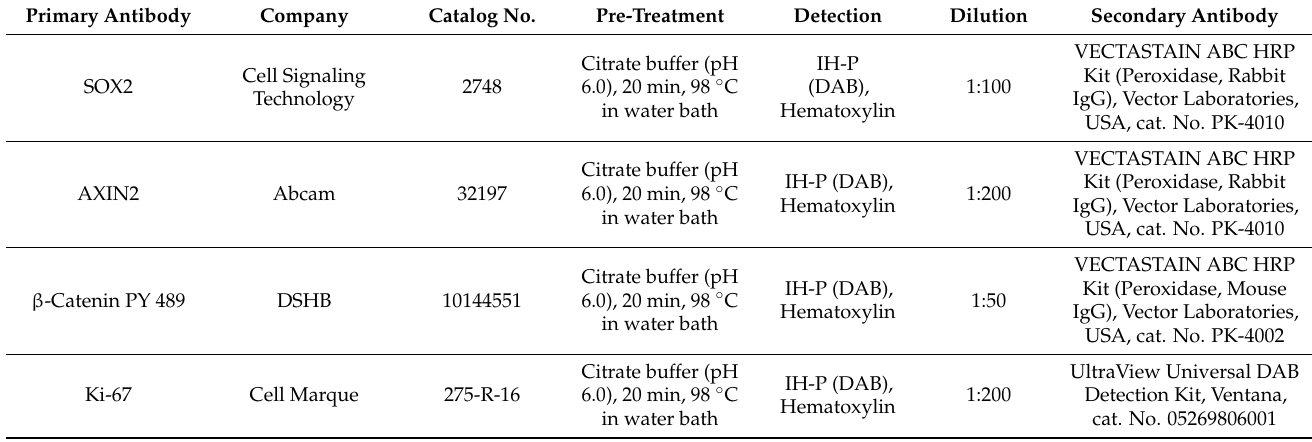
Table 1. List of primary and secondary antibodies used for immunohistochemical analysis.